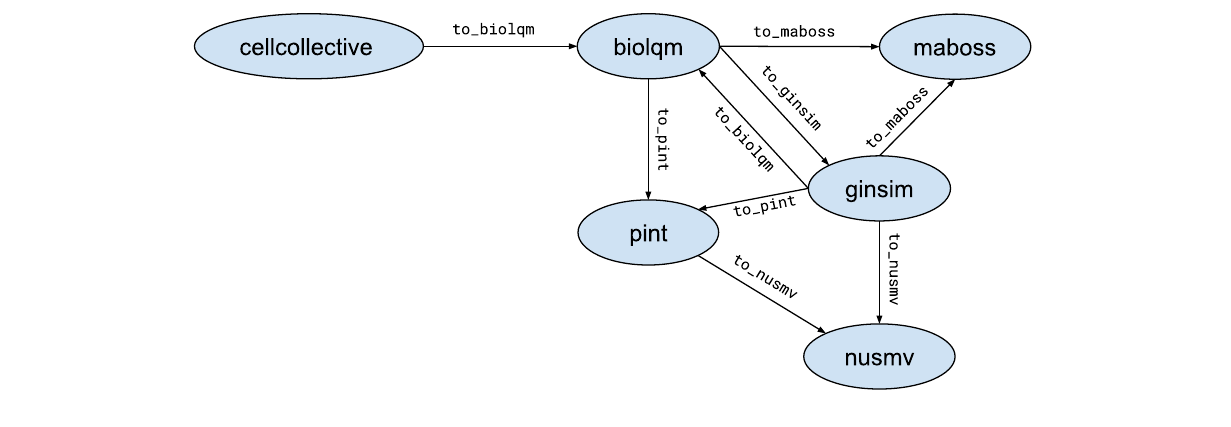
FIGURE 2 | Supported model conversions between Python